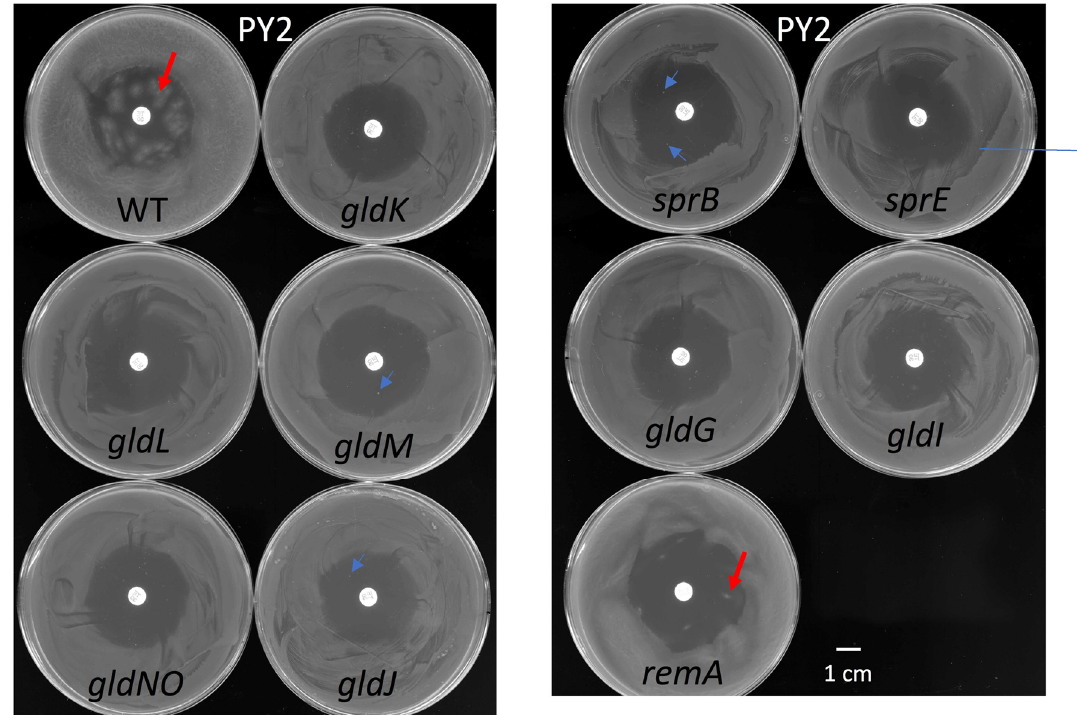
Figure 10. The antibiotic resistance of WT and the mutants in diffusion test. For the disk diffusion test, the PY2 plates were incubated at 25 °C for 5 days. Spreading colonies of F. johnsoniae WT and remA mutant were clearly found as isolated colonies within the inhibition zone (red arrows), although the colonies of remA were smaller than those of WT. One or two very small rigid colonies were found within the inhibition zone of gldM , gldJ , and sprB mutants (blue arrows).